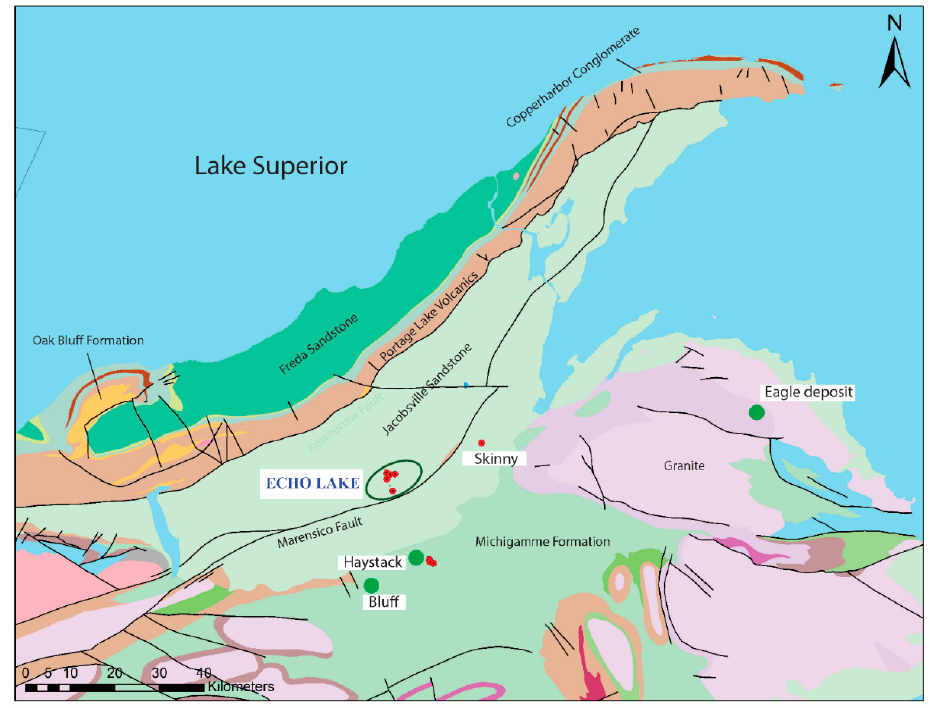
Figure 2. Location of Echo Lake prospect in the Upper Peninsula of Michigan, near the southern shore of Lake Superior [17]. Green circles indicate a few other metal prospects and mines in the area. Red circles indicate drill core locations.